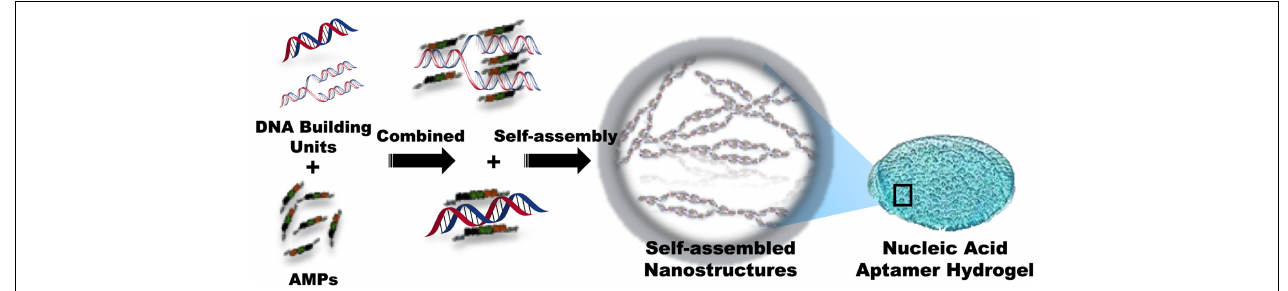
FIGURE 9 | Schematic representation of the composition of nucleic acid aptamer hydrogel with conjugated